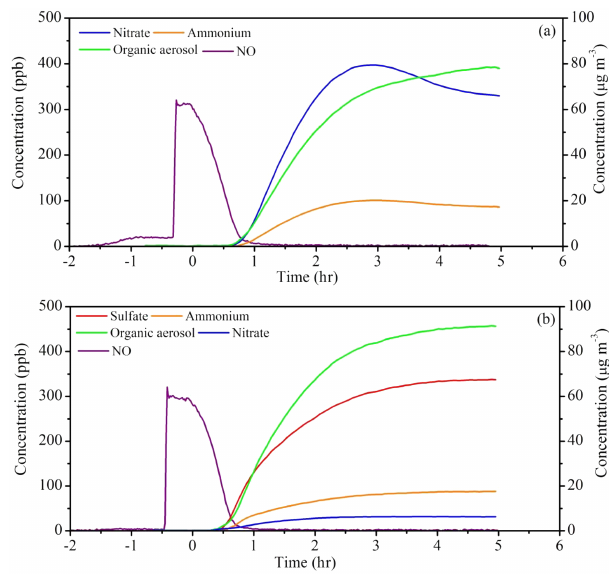
Figure 3. Concentration–time plots of NO (left y axis) and particle- phase species (right y axis) during the photochemical aging of emissions from vehicle I. (a) Without and (b) with SO 2 . The con- centrations of particle-phase species are wall-loss-corrected. At time = 0h, the black lamps were turned on.